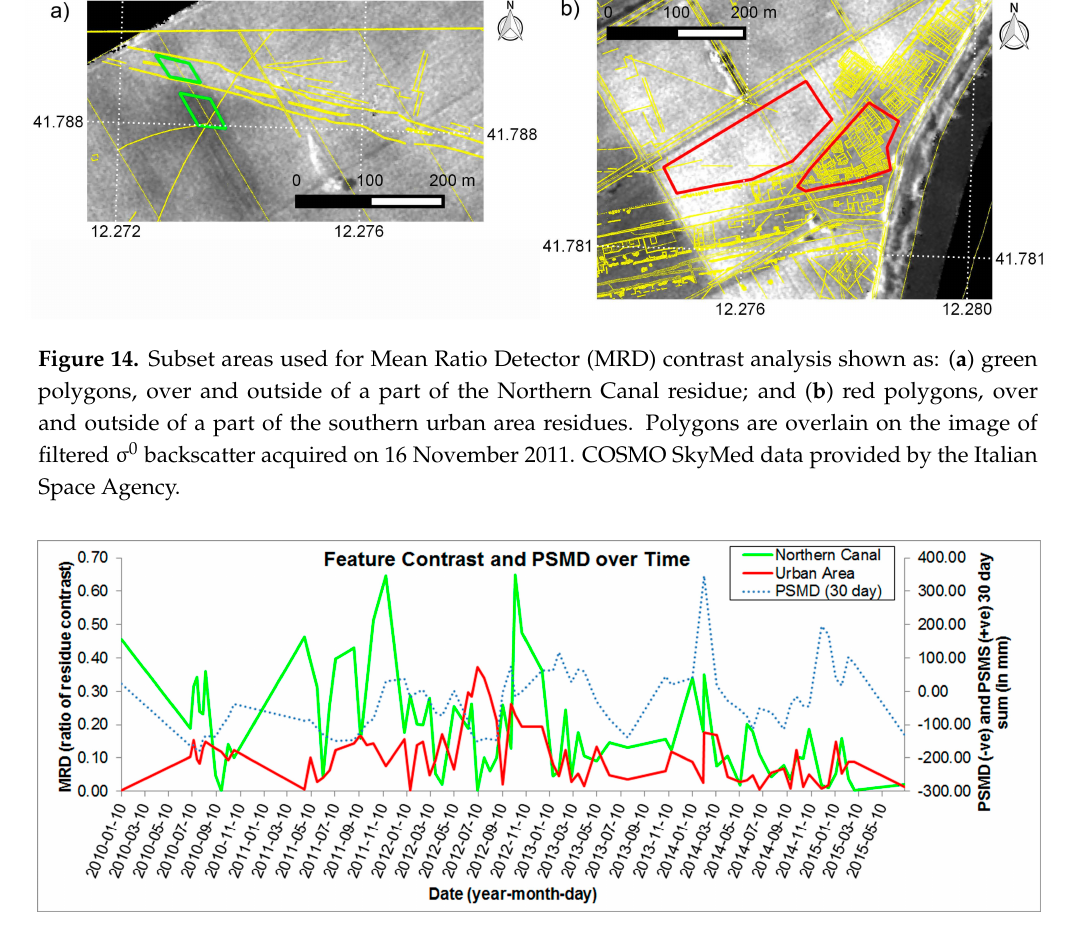
Figure 15. Graph showing clarity (contrast) of the two archaeological residues of the Northern Canal (in green) and the southern urban area (in red), plotted over time and with PSMD. The clarity of residues is quantified as a ratio (MRD). For the PSMD, negative values correspond to high PSMD (dry conditions), while positive values correspond to high PSMS (wet conditions).